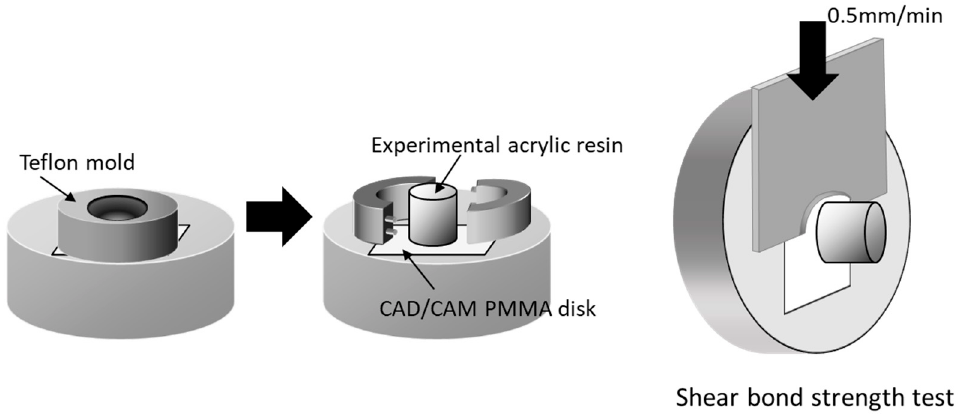
Figure 2. Schematic illustration of shear bond strength test. Acrylic resin column was cemented onto PMMA surface with a Teflon jig mold. Shear bond strength was measured using a universal testing machine with a crosshead speed of 0.5 mm/min (reproduced with permission from Maruo Y. et al. J. Appl. Biomater. Funct. Mater. 2017 [25]).